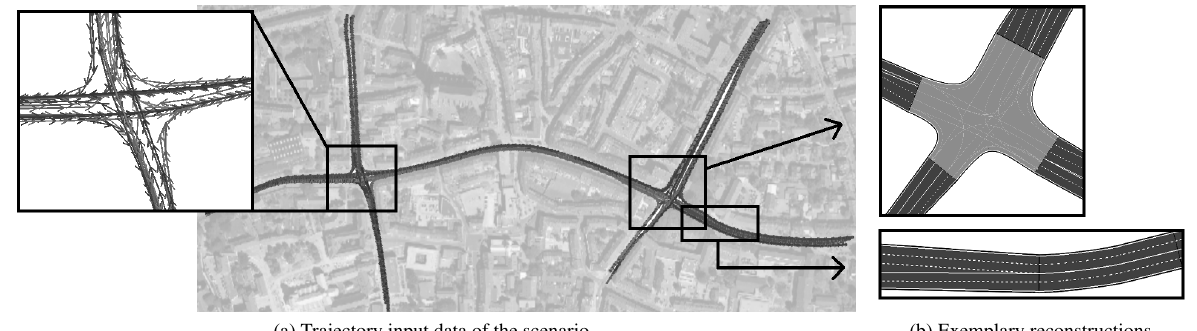
Figure 5. Raw trajectory input data of the scenario and exemplary reconstructions as quantitative results.